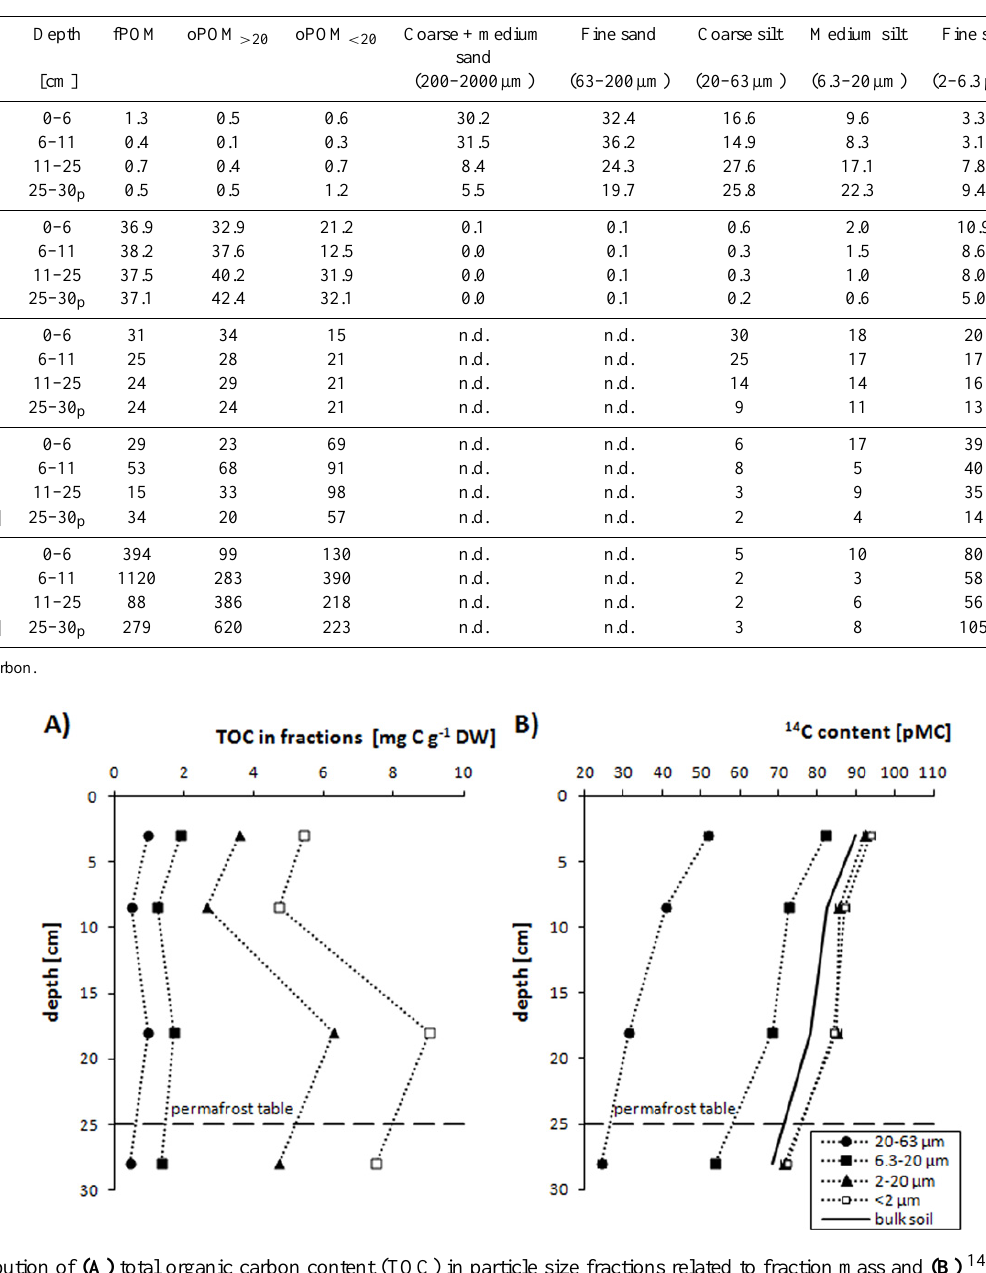
Fig. 1. Distribution of (A) total organic carbon content (TOC) in particle size fractions related to fraction mass and (B) 14 C content (one- sigma measurement uncertainties are indicated by bars on each point) over depth in the coarse silt (20–63µm), medium silt (6.3–20µm), fine silt (2–6.3µm) and clay ( < 2µm)